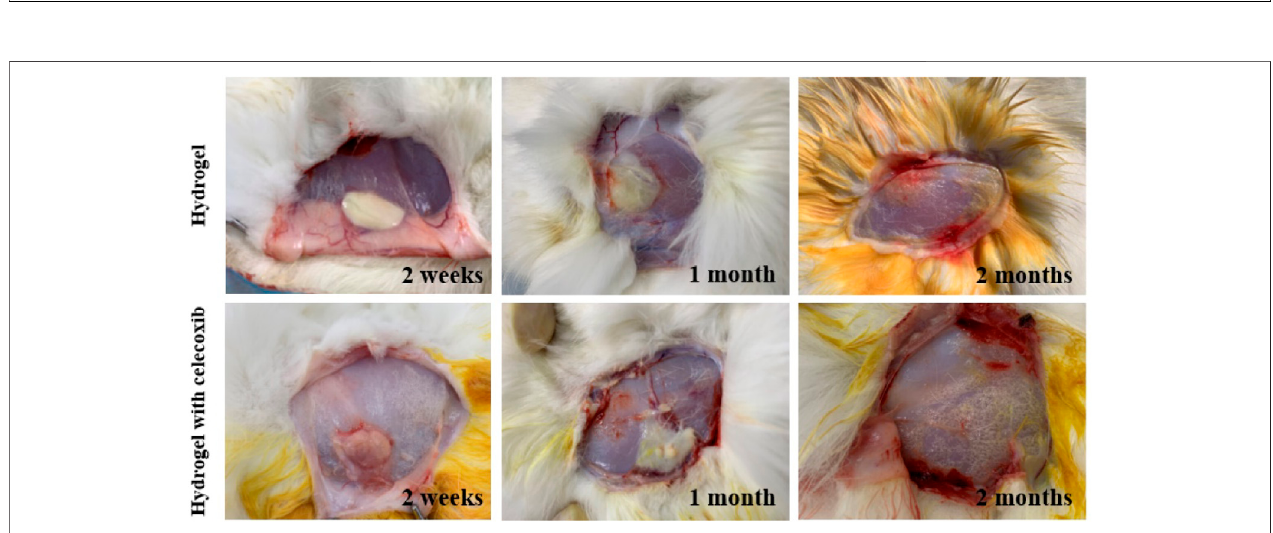
FIGURE 6 | The degradation and histocompatibility analysis of hydrogel implanted subcutaneously at time of 2 weeks, 1 month, and 2 months after injection.